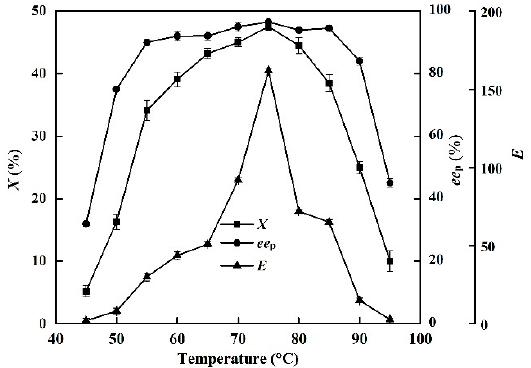
Figure 3. Effe c t of reaction temperature (from 45 °C to 95 °C) on the conversion degree, enantiomeric excess of product and enantioselectivity of EST10 using [OmPy][BF 4 ] as a co-solvent in the presence of enzyme EST10 (15 mg/mL). The concentration of racemic ibuprofen ethyl ester was 2.5 mg/mL. The values are means of three independent experiments.